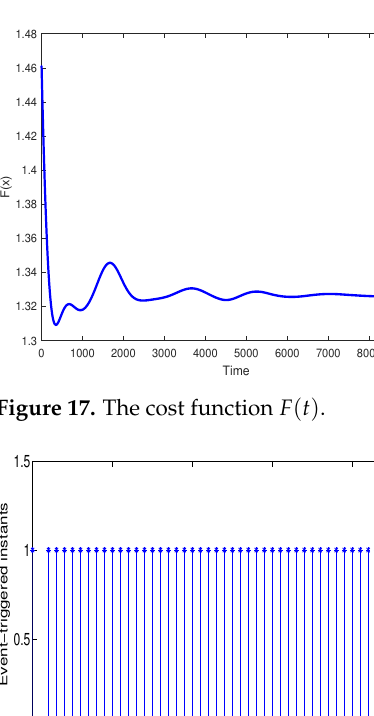
Figure 16. The trajectories of x i 2 ( t k ) .